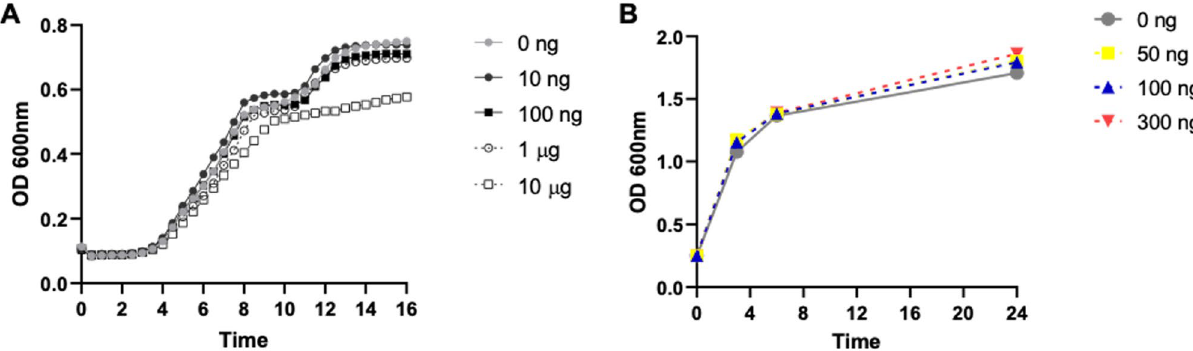
Figure 1. ( A ) Dose effect of mycolactone on S. aureus growth measured by OD600 for up to 16 h. ( B ) Comparison of OD600 of S. aureus incubated alone, or with mycolactone or EtOH at 3H, 6H, and